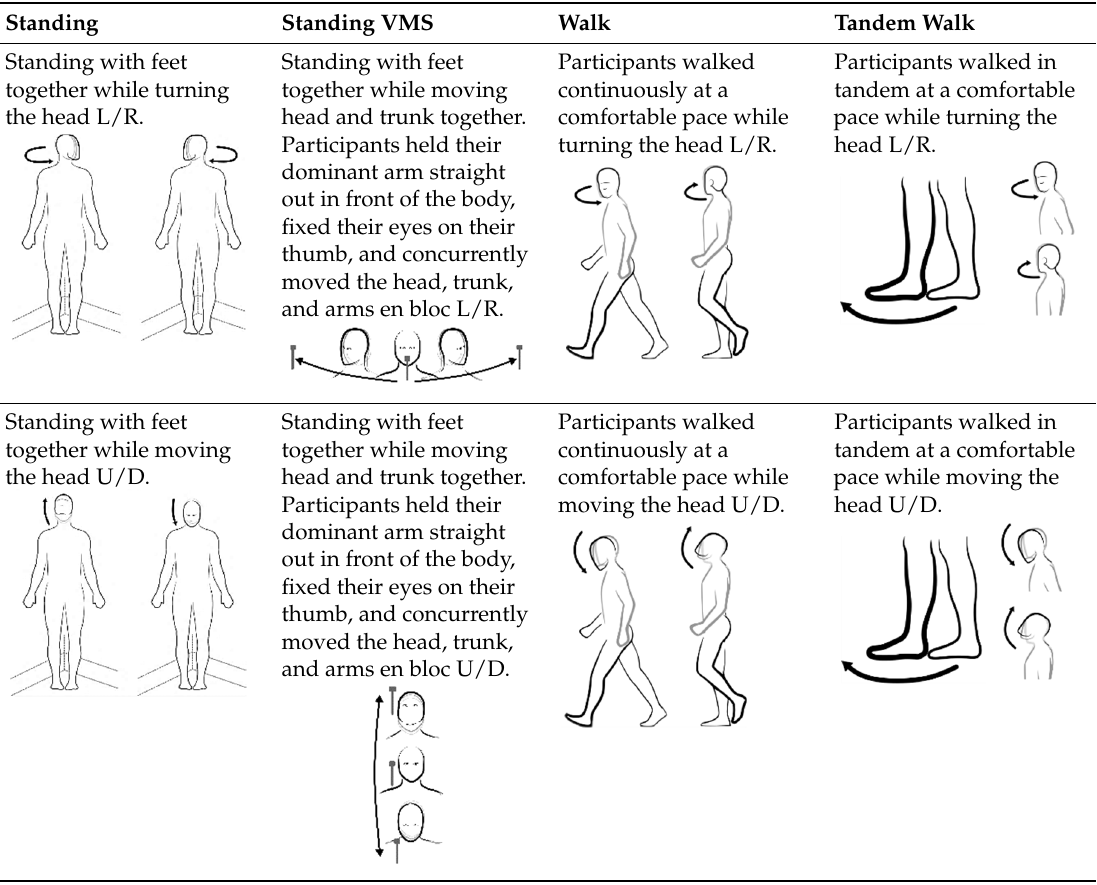
Table 1. Description of standing and walking conditions.